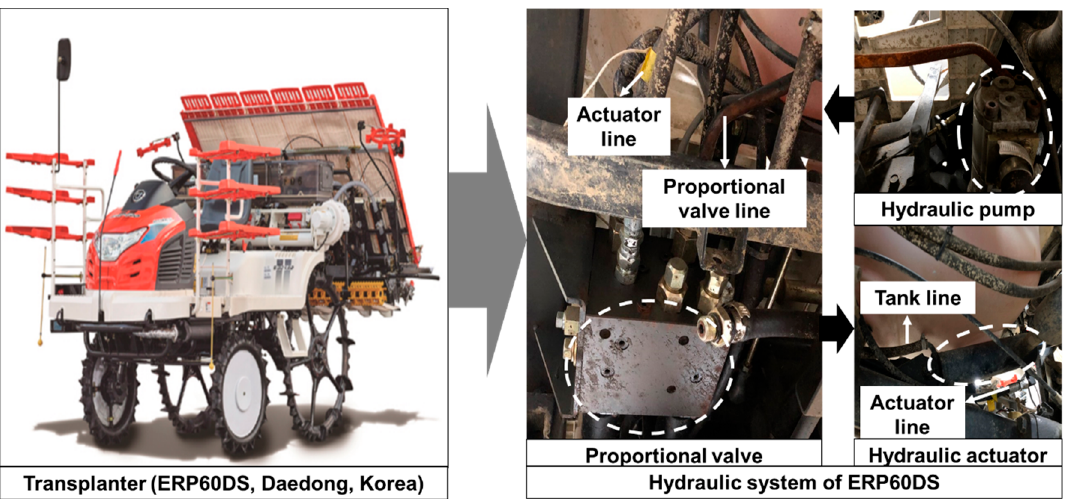
Figure 1. Rice planting machine and its hydraulic system.